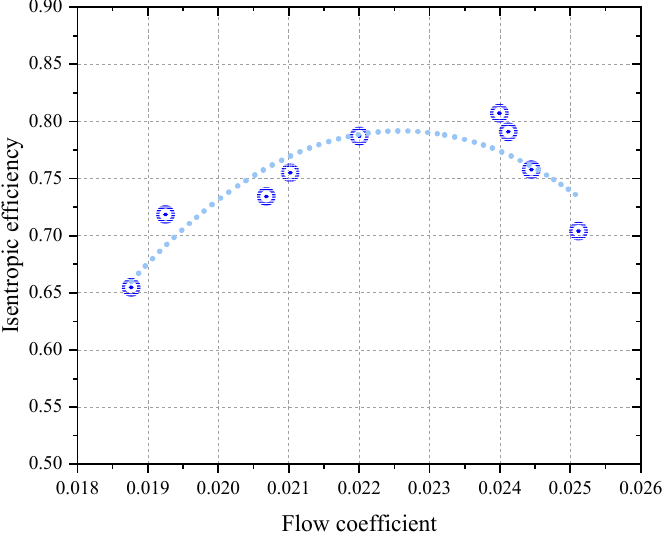
Figure 14. Dimensionless isentropic efficiency performance curve (@ 31,000 ± 1000 RPM).